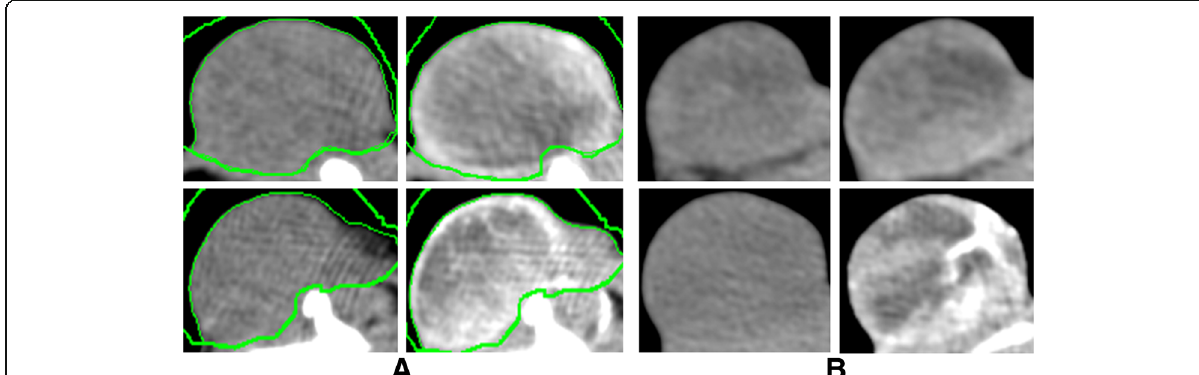
Fig. 6 Imaging tumors with CE-CT and native CT. Panel a and b show details of xenograft tumors for cell line A549 and H1299, respectively. The upper and lower rows depict images for non-co-transplanted and co-transplanted tumors, respectively. The left and right columns in a and b depict images from native and contrast-enhanced images. Compare the different degree of contrast enhancement between non-co-transplanted (upper row) and co-transplanted (lower row) tumors. a Upper row: non-co-transplanted tumor with moderate contrast enhancement from native (left column) to contrast-enhanced (right column) image. Lower row: co-transplanted tumor with high contrast enhancement from native (left column) to contrast-enhanced (right column) image. b Upper row: non-co-transplanted tumor with modest contrast enhancement from native (left column) to contrast-enhanced (right column) image. Lower row: co-transplanted tumor with high contrast enhancement from native (left column) to contrast-enhanced (right column) image and vessel within the tumor becoming visible in co-transplanted contrast-enhanced image